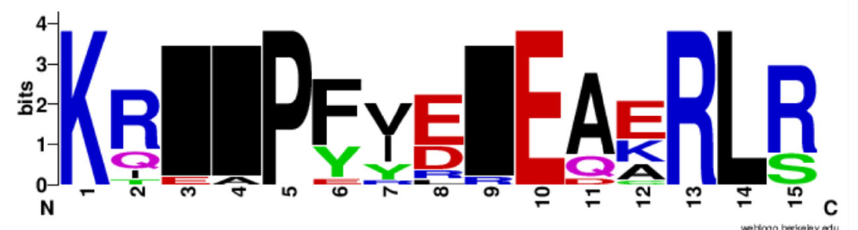
Figure 4. Conserved domain pattern in Sox proteins across Bos sp.